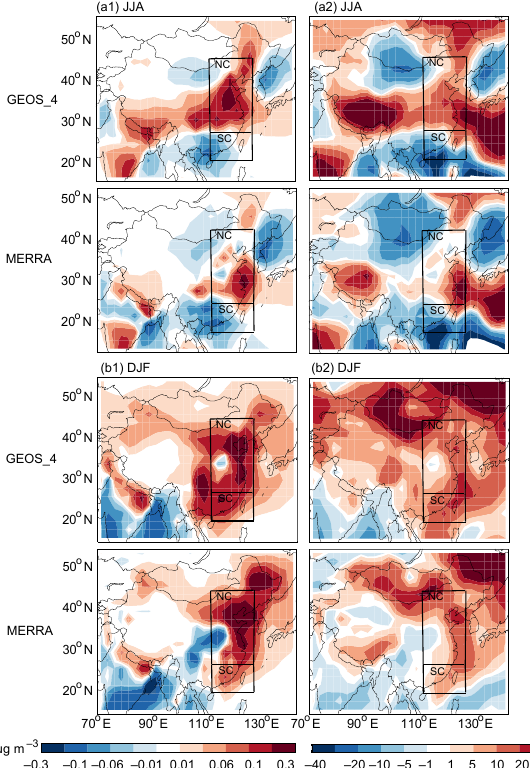
ences in simulated JJA mean surface BC concentrations between weakest (1988, 1993, 1995, 1996, and 1998) and strongest (1990, 1994, 1997, 2004, and 2006) EASM years during 1986–2006 from model simulations VMETG4 and VMET. (b1, b2) Same as pan- els (a1) and (a2) , respectively, but for absolute (µgm − 3 ) and per- centage (%) differences in simulated DJF mean surface BC concen- trations between weakest (1990, 1993, 1997, 1998, and 2002) and strongest (1986, 1996, 2001, 2005, and 2006) EAWM years. The enclosed areas are defined as northern China (NC; 110–125 ◦ E, 28– 45 ◦ N) and southern China (SC; 110–125 ◦ E, 20–27 ◦